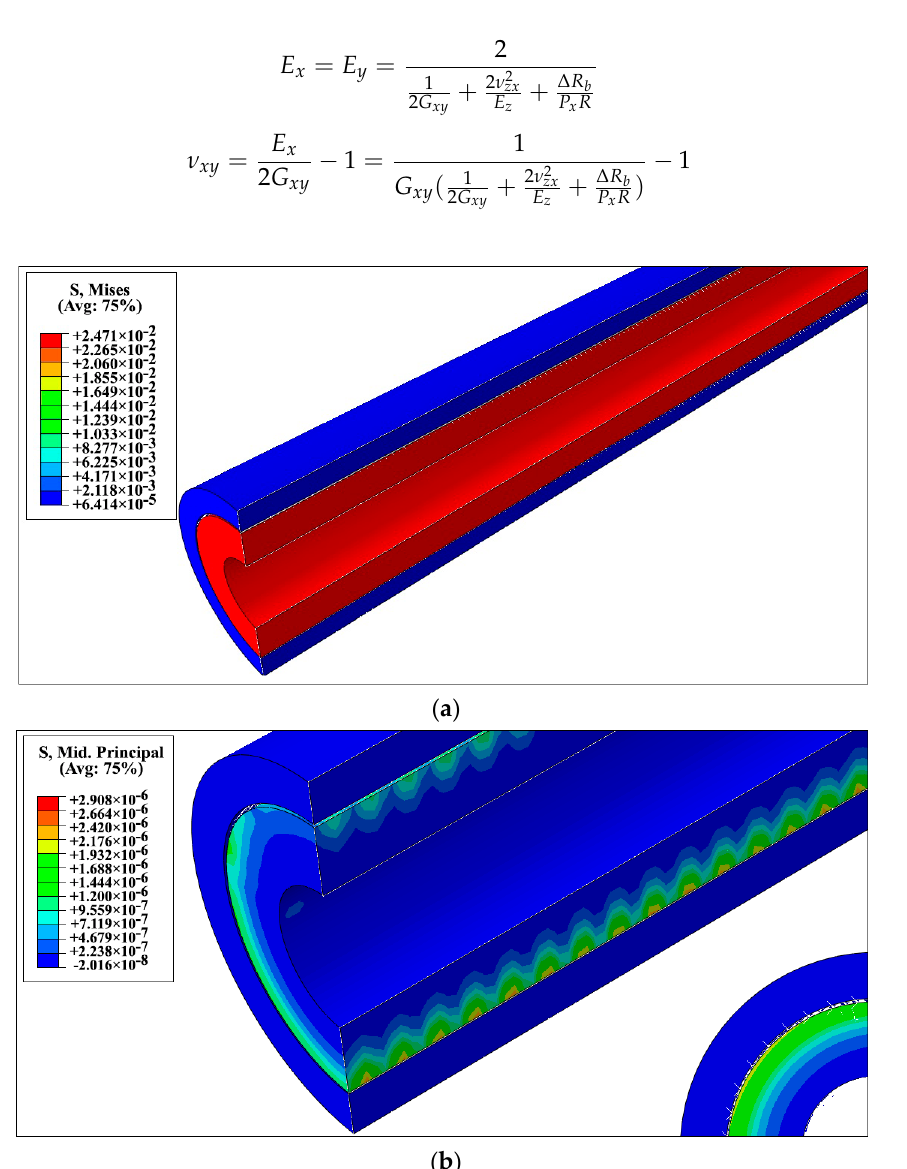
Figure 8. Results of finite element simulation of equivalent fiber (EF) under uniaxial loading ( a ) contour plots of von Mises stress ( b ) mid-principal stress distribution.